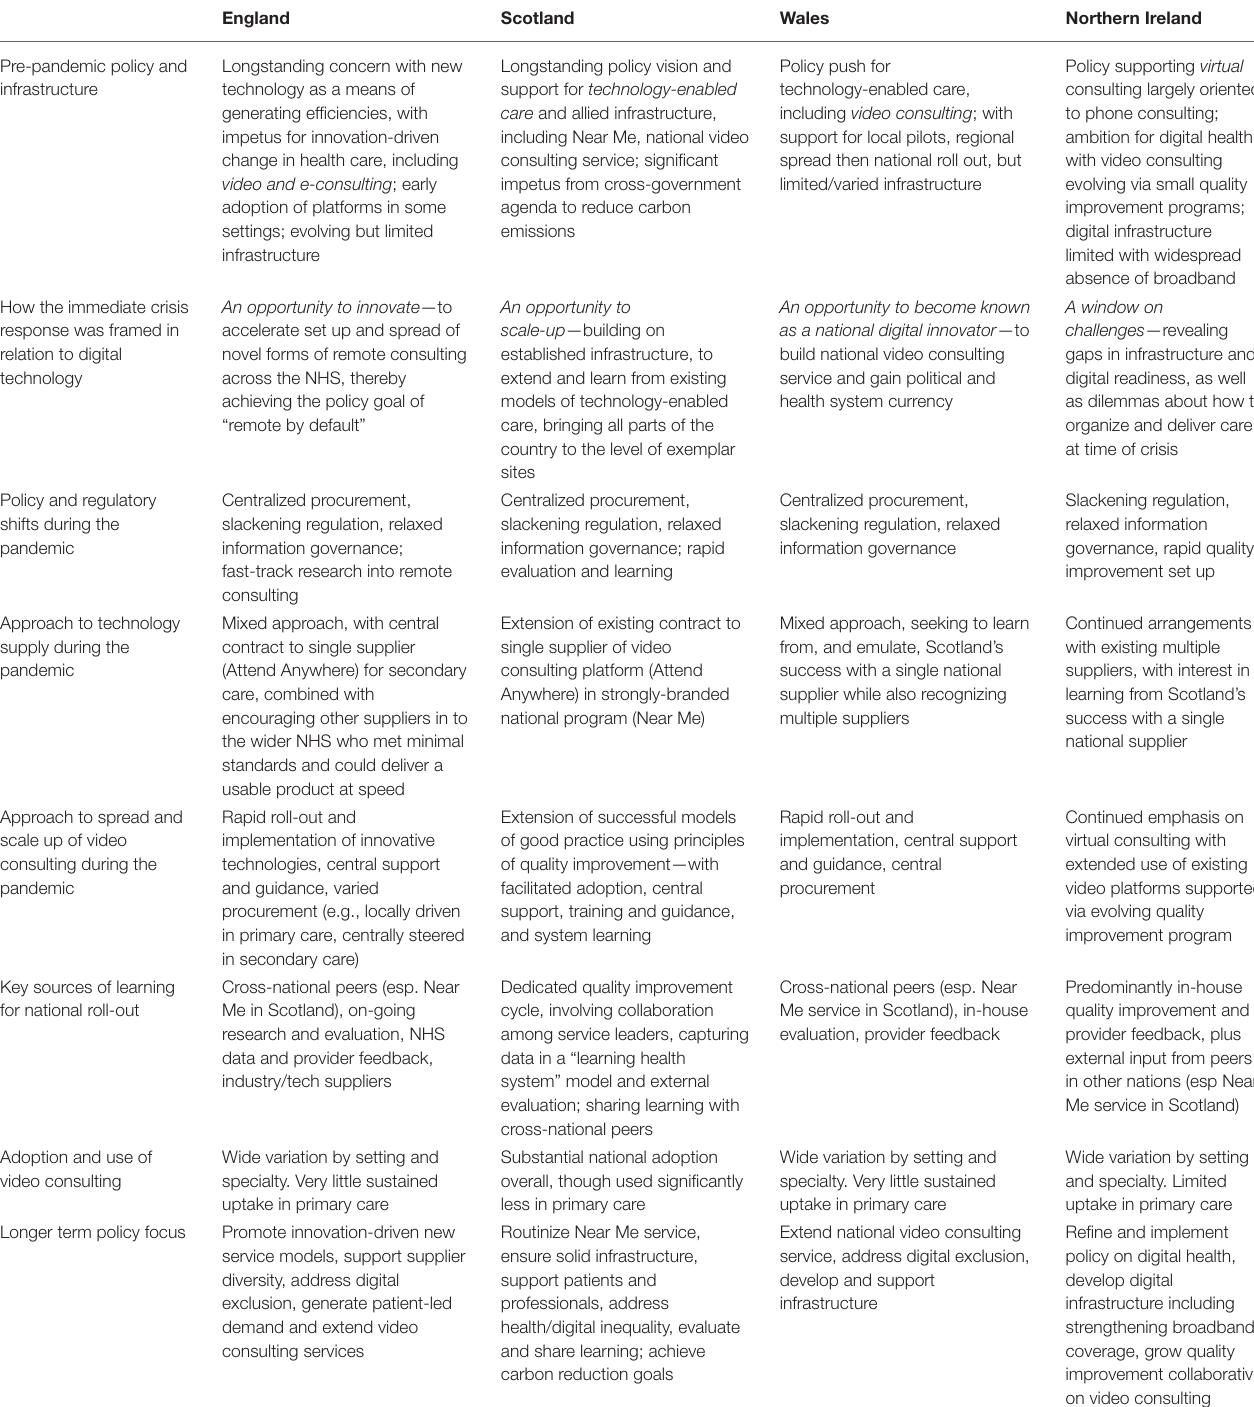
TABLE 3 | Overview of policy approaches to video consulting across the four nations, before and during the COVID-19